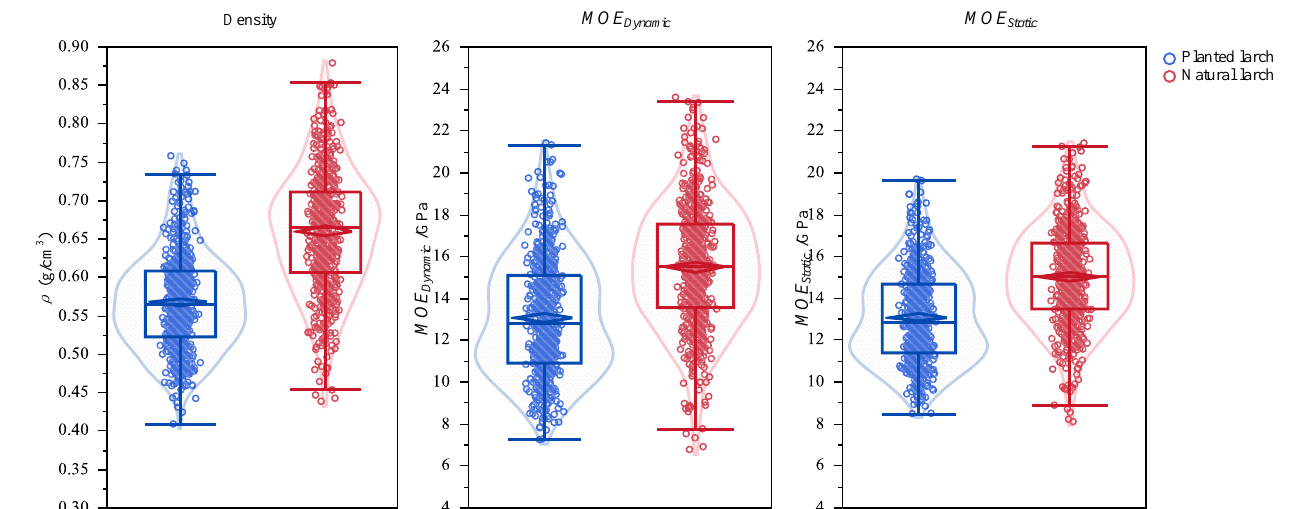
Figure 5. Density and MOE test results of the natural and planted larch dimension lumber. Note: The horizontal line in the boxplots are the 5th, 25th, 50th, 75th, and 95th percentile; inside the boxplot is the confidence diamond plot of the mean value, and outside the boxplot is the violin plot.